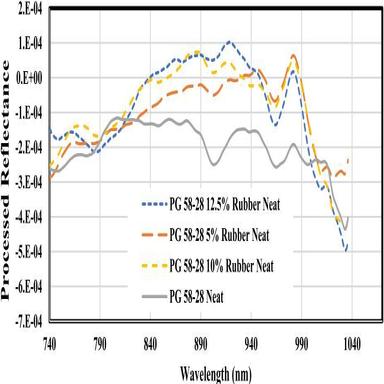
Comparison of the PG 58-28 neat binders with different percentages of rubber.